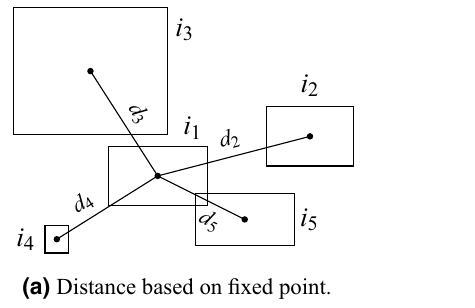
(a) Distance based on fixed point. (b) Suggested distance function. Figure 12. Possible distance